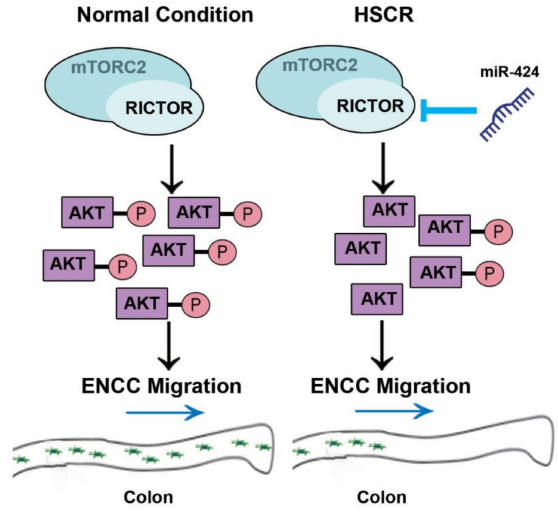
Figure 9. Schematic illustration of miR-424-mediated regulation of AKT phosphorylation and ENCC migration. Up-regulation of miR-424, observed in HSCR tissues, results in decreased RICTOR expression and thereby inhibits AKT phosphorylation. This, in turn, impairs ENCC proliferation and migration, consequently contributing to the pathogenesis of